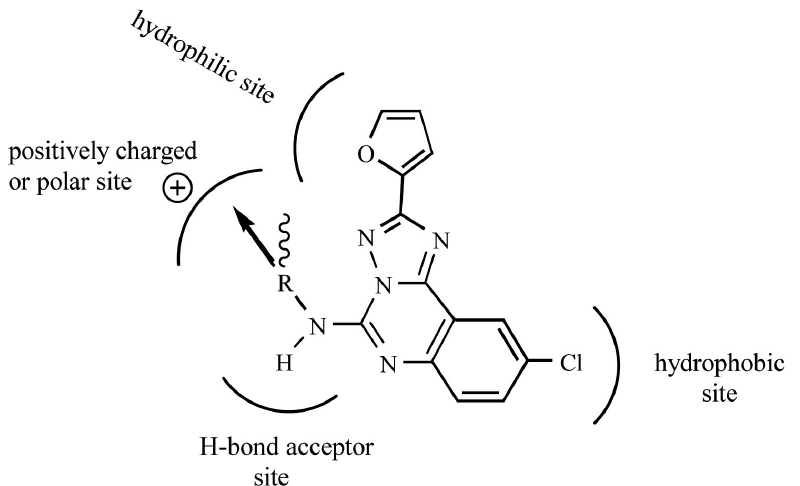
Figure 3. Model for the binding of triazoloquinazoline derivatives to the human A model was generated using QSAR equation (5) and information from the docking study by Moro et. al. [16]. The direction of substitution is represented by the wavy bond, the arrow indicates the bond axis and direction. The bond axis is tilted by about 45° from the plane of the membrane. The sterimol length parameter L is defined as the length of a substituent along the bond axis. Substituents containing high L values were favored, whereas high sterimol width parameters orthogonal to L, B found to be unfavorable for binding of compounds to the human A